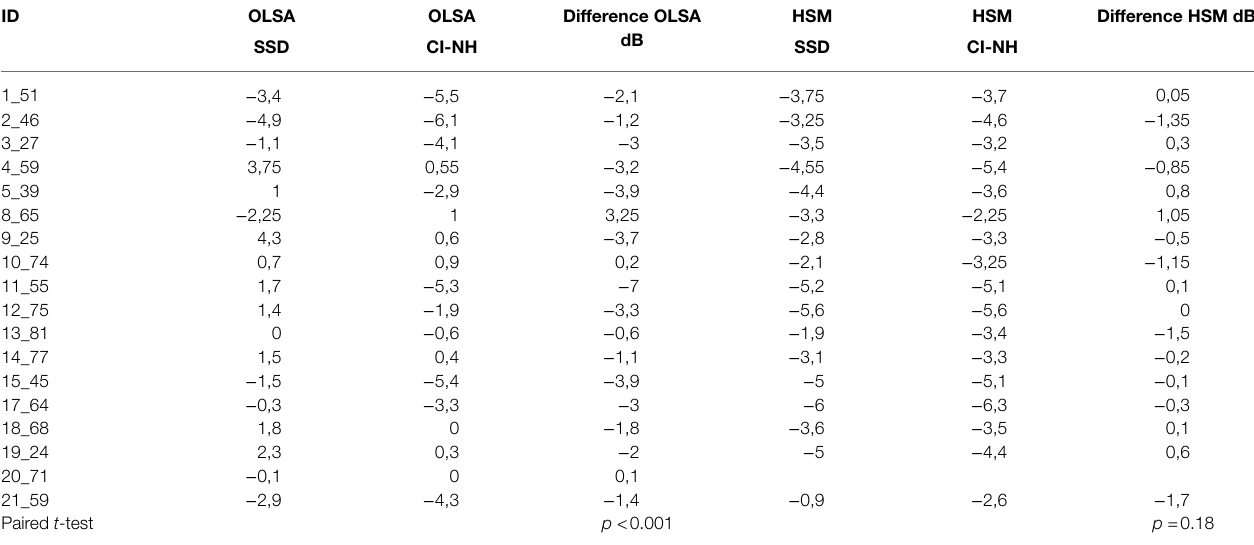
TABLE 4 | Speech test results.